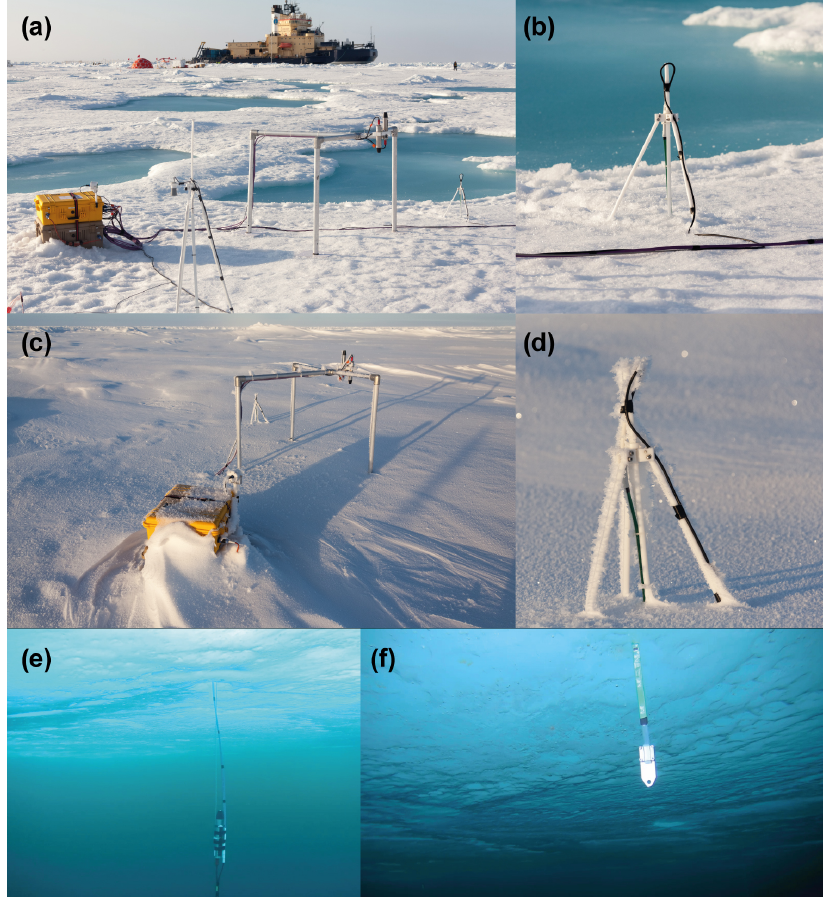
Figure 3. (a) Picture of the radiation station setup a few days after deployment on 23 August 2018: from left to right one can see the two cases with electronics, separate batteries and a webcam, the tripod holding a snow height sensor and the thermistor chain, the radiation frame holding the RAMSES radiometers, and the small tripod holding the light chain. (b) Close-up of the light chain. (c, d) The system state on 15 September 2018. (e) Under-ice RAMSES sensor measuring transmitted hyperspectral irradiance. (f) Lowermost portion of the light sensor chain protruding the ice–ocean interface. Note the attached metal weight to keep the chain vertical in the water